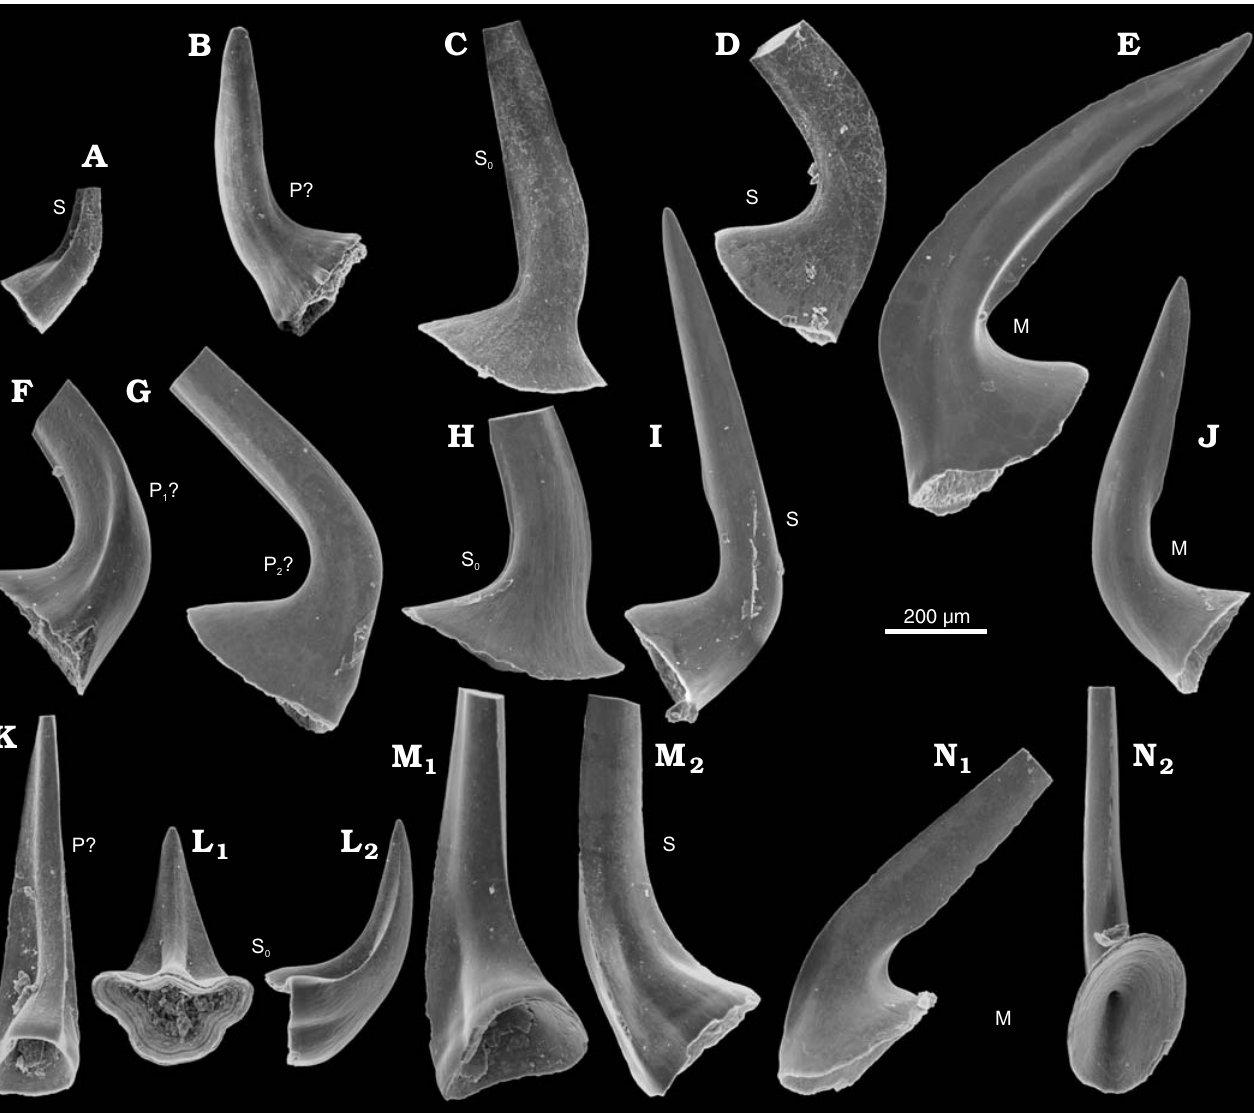
Fig. 3. Conodonts from the probably latest Furongian Ust-kut Formation from the exposure at Pashino on the Angara River, Siberia, Russia, samples Ang-4, block No. 1 (A–E; Fig. 1) and Ang-1, topmost limestone layer (F–N; Fig. 2B). A , K – N . Utahconus (?) eurypterus (Abaimova, 1971), ZPAL N. IV/163, 168, 169, 170, and 172, respectively. B – J . Laurentoscandodus triangularis (Furnish, 1938), ZPAL N. IV/165, 166, 167, 173, 174, 175, 177, and 176, respec- tively; in posterior views, except for medial view in L 1 and occlusals view in M 1 and N 2 . Tentative identification of elements locations indicated S, S 0 , M,